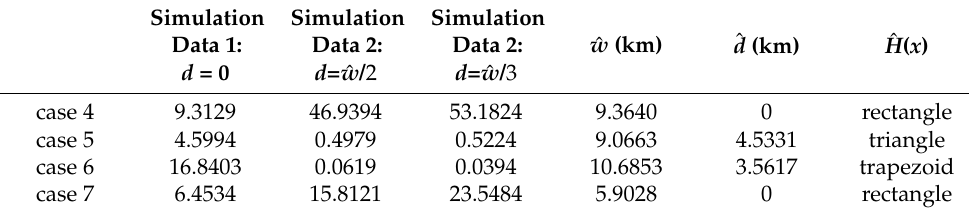
Table 3. Likelihood distance between simulation data and data to be